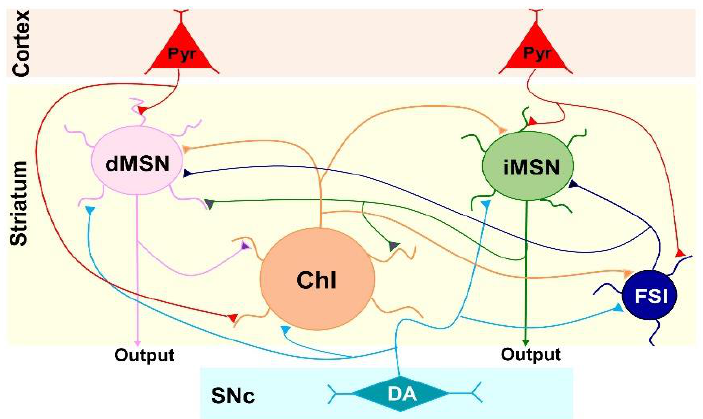
Figure 7. Schematic illustration of the microcircuit of the striatum. dMSN, direct pathway MSN; iMSN, indirect pathway MSN; ChI, cholinergic interneuron; FSI, fast-spiking interneuron; Pry, pyramidal neuron in the cortex; DA, dopaminergic neuron in the substantia nigra compacta (SNc). The axonal inputs are representatives; some inputs could target to both somata and dendrites.